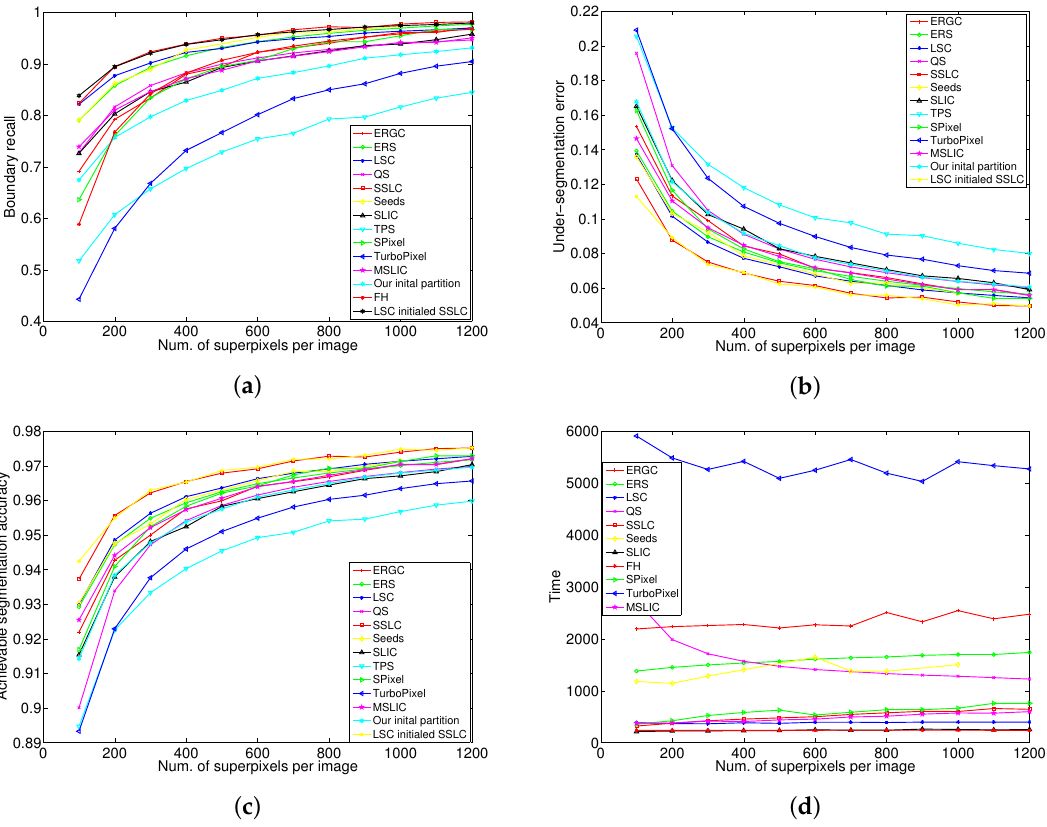
Figure 5. Performance vs. number of superpixels on the Berkeley Segmentation Dataset (BSD) benchmark. Higher Boundary Recall (BR) and Achievable Segmentation Accuracy (ASA) values indicate a better performance in superpixel alignment; lower Under-segmentation error (UE) values represent less error in the superpixel result. ( a ) Boundary recall; ( b ) Under-segmentation error; ( c ) Achievable segmentation accuracy; ( d )